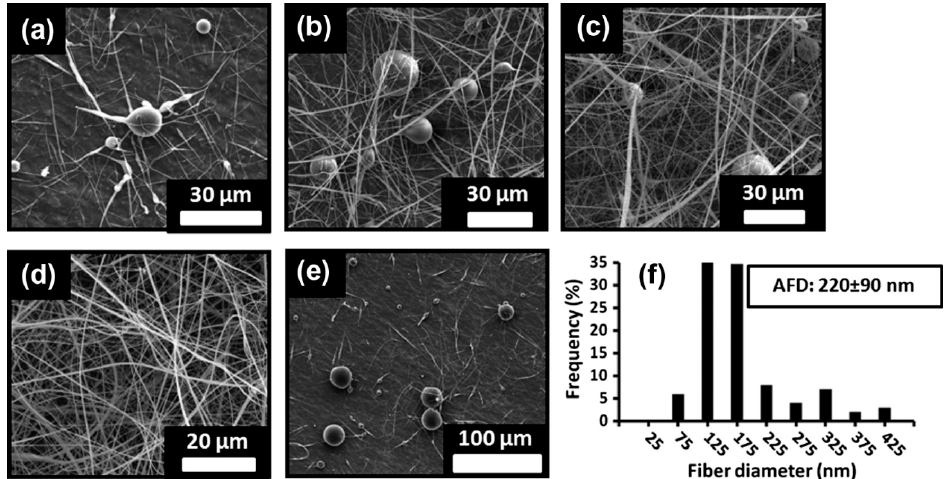
Figure 5. Scanning Electron Microscopy (SEM) images of electrospun fibers prepared with ( a ) 120% ( w/v ), ( b ) 130% ( w/v ), ( c ) 140% ( w/v ), and ( d ) 150% ( w/v ) β CD solutions in 10% NaOH medium, and ( e ) 150% ( w/v